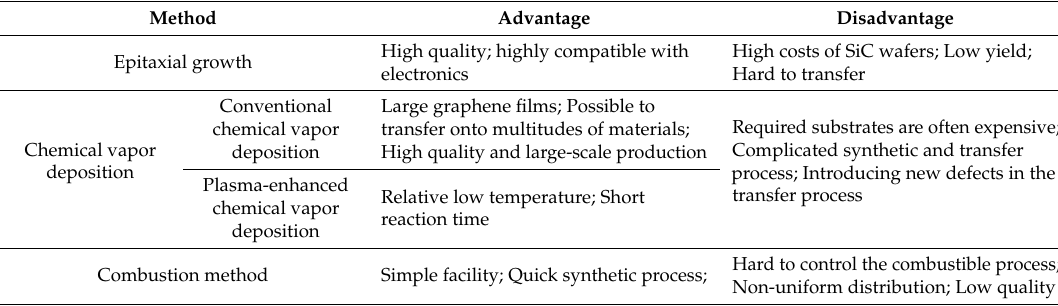
Table 1. A summary of three different methods to synthesize graphene.